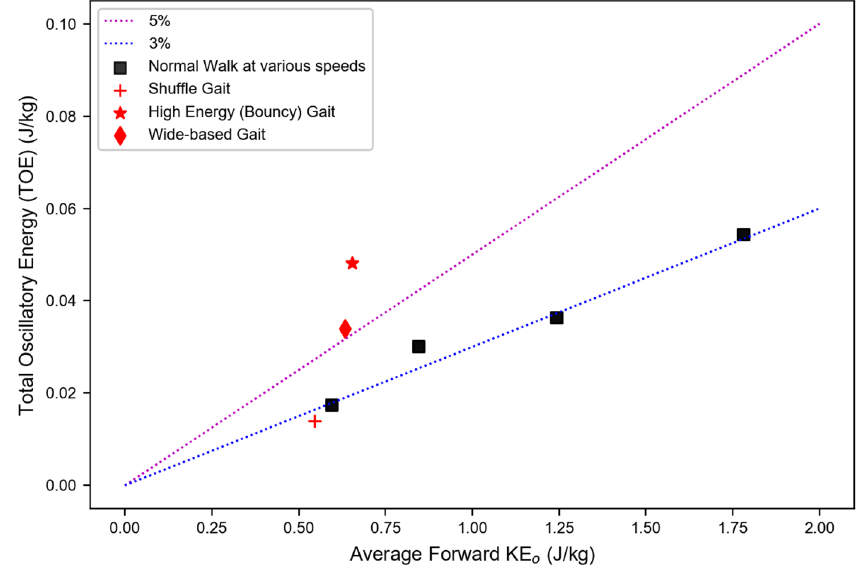
Figure 3. Total oscillatory energy (TOE) versus 𝐾𝐸 (cid:2868) . The slope of the dotted lines is the OEP.